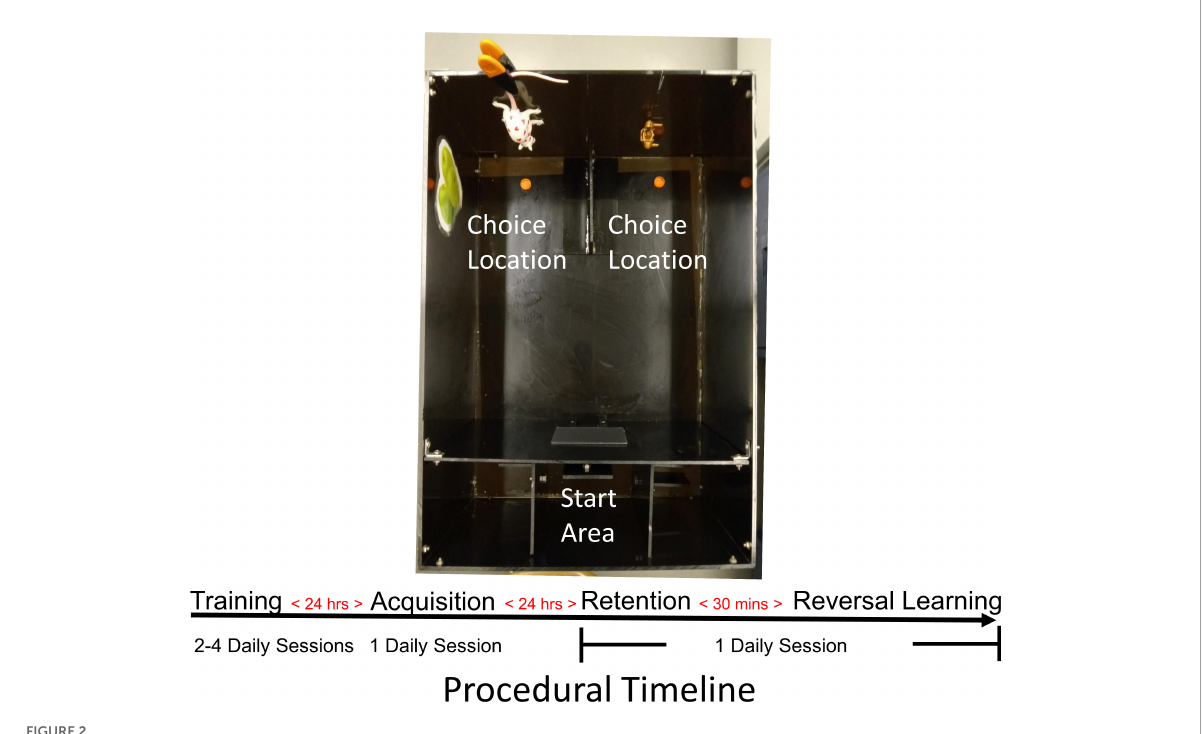
FIGURE2 Mouse probabilistic reversal learning task. Photograph of the apparatus used for testing mice in the acquisition and reversal learning of a spatial discrimination with probabilistic reinforcement. Food-restricted mice were first trained to recover sweetened cereal pieces from food wells in choice areas. After achieving criterion, mice received an acquisition test the following day. The day after acquisition, mice first received a retention test followed 30 min later by a reversal learning test. In all tests, a 80/20 probabilistic reinforcement schedule was used such that the “correct” choice was reinforced with 80%